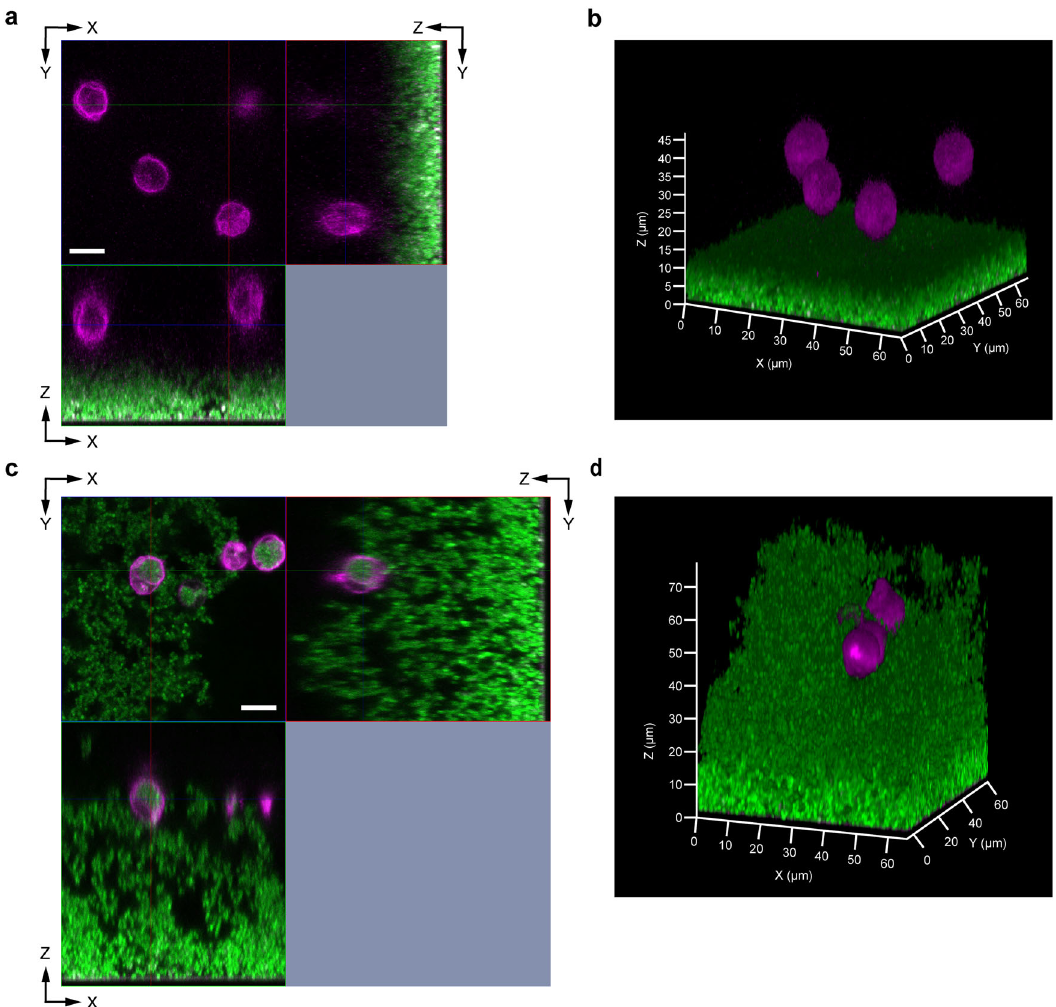
Fig. 5 iCBio fi lm imaging for neutrophil phagocytosis of S. aureus bio fi lm cells. Bio fi lms of S. aureus MR23 and neutrophils from mice were stained with FM1-43 (green) and Alexa 647-conjugated anti-Ly-6G (magenta), respectively. Neutrophils were also stained with FM1-43 but can be distinguished from bacterial cells because of their size and shape. Large magenta shapes represent neutrophils, while green shapes represent bio fi lm cells. The specimens were soaked in PBS ( a , b ) or 37.1% (w/v) ioversol ( c , d ) and observed using an LSM880 microscope with a ×63 objective lens and an Airyscan super- resolution unit. a , c Orthogonal images. Scale bars are 10 μ m. b , d 3D